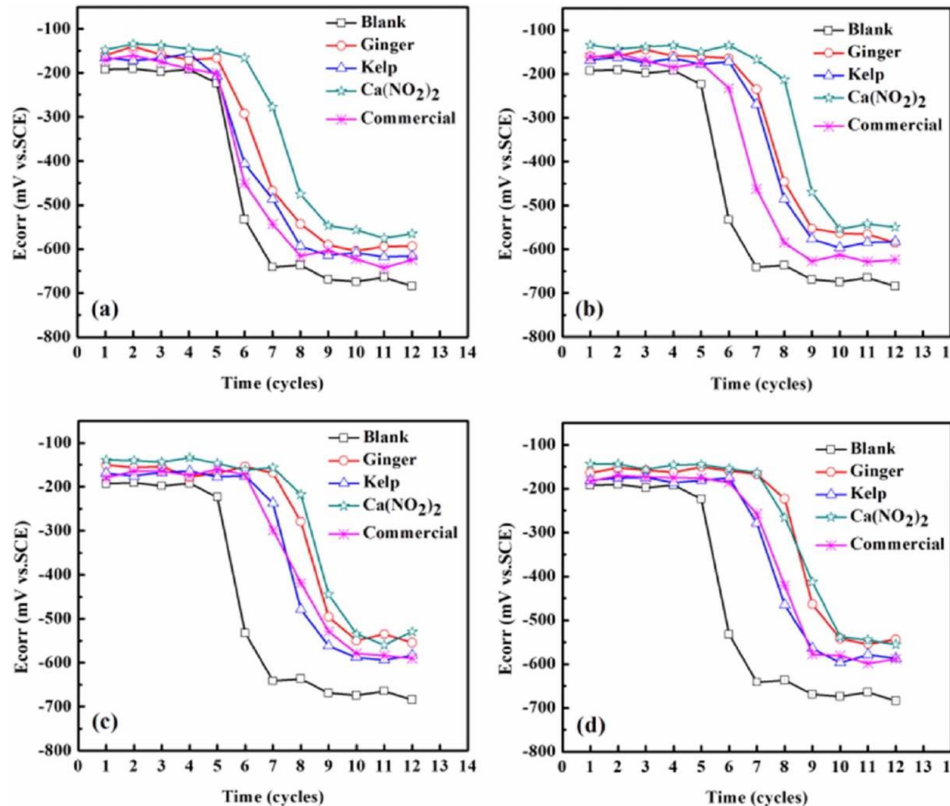
Figure 8. E corr of steel bars embedded into cement mortars containing different corrosion inhibitors at different amounts: ( a ) 0.5 wt.%; ( b ) 1 wt.% ; ( c ) 2 wt.%; and ( d ) 4 wt.% Reprinted from [89],